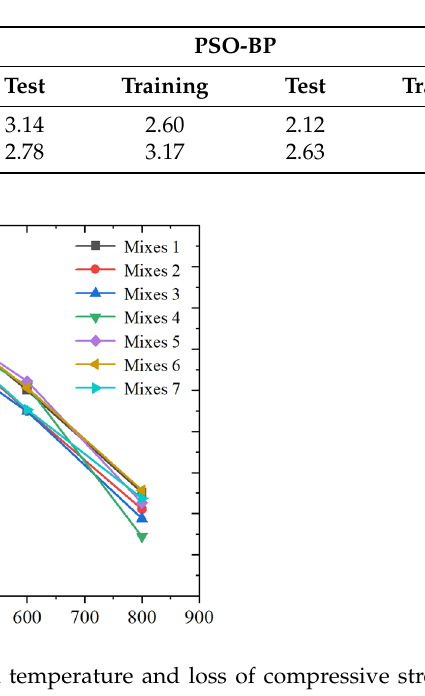
Figure 8. Correlation of RF modeling. Table 5. Error evaluation.